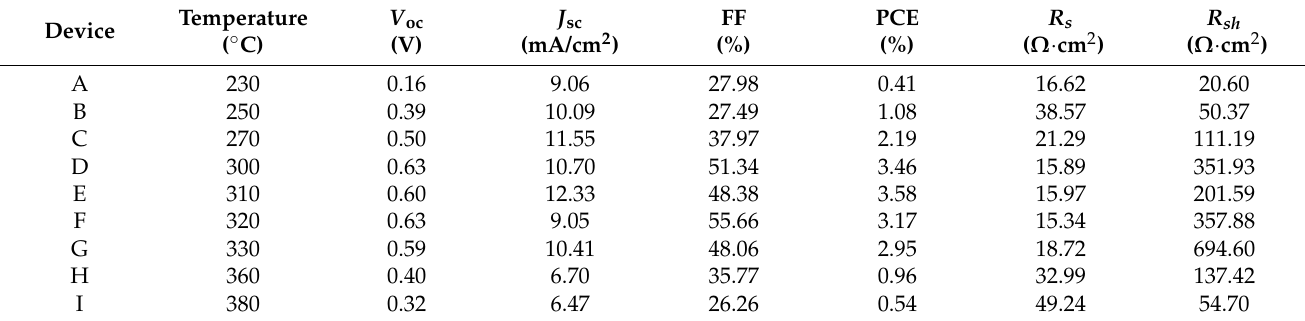
Figure 4. ( a ) Cross-section SEM images of ITO/ZnO/CdSe/CdTe/Au; J–V curves of ITO/ZnO/CdSe/CdTe/Au with different annealing temperatures ( b ) under light and ( c ) under dark; ( d ) the corresponding external quantum efficiency (EQE) spectra. Table 1. Summarized performance of NC solar cells with different annealing temperatures (Figure